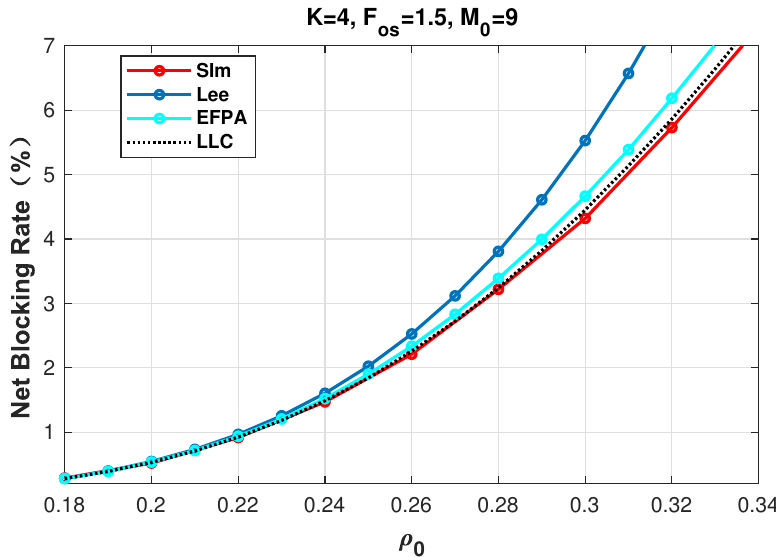
Figure 5. Network blocking performance of different methods with K = 4, F OS = 1.5, and M 0 =